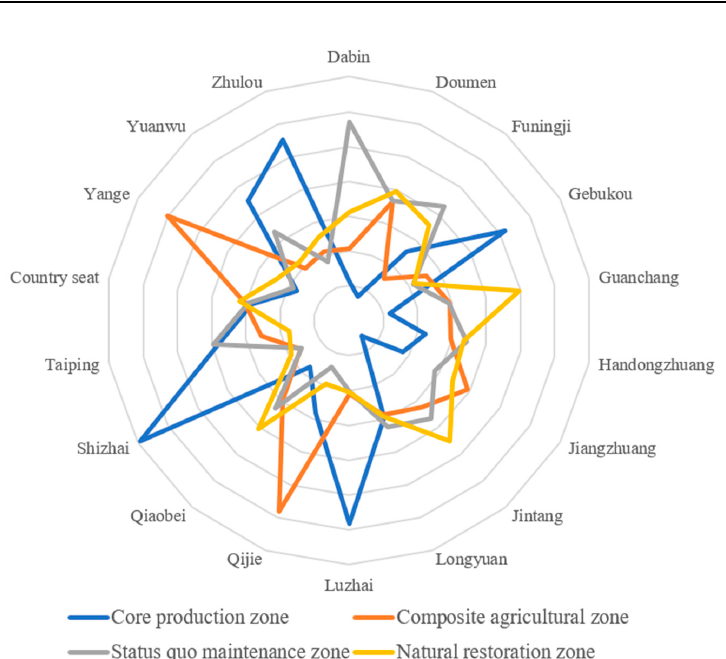
Figure 7. NRCA value of villages and towns in Yuanyang County.